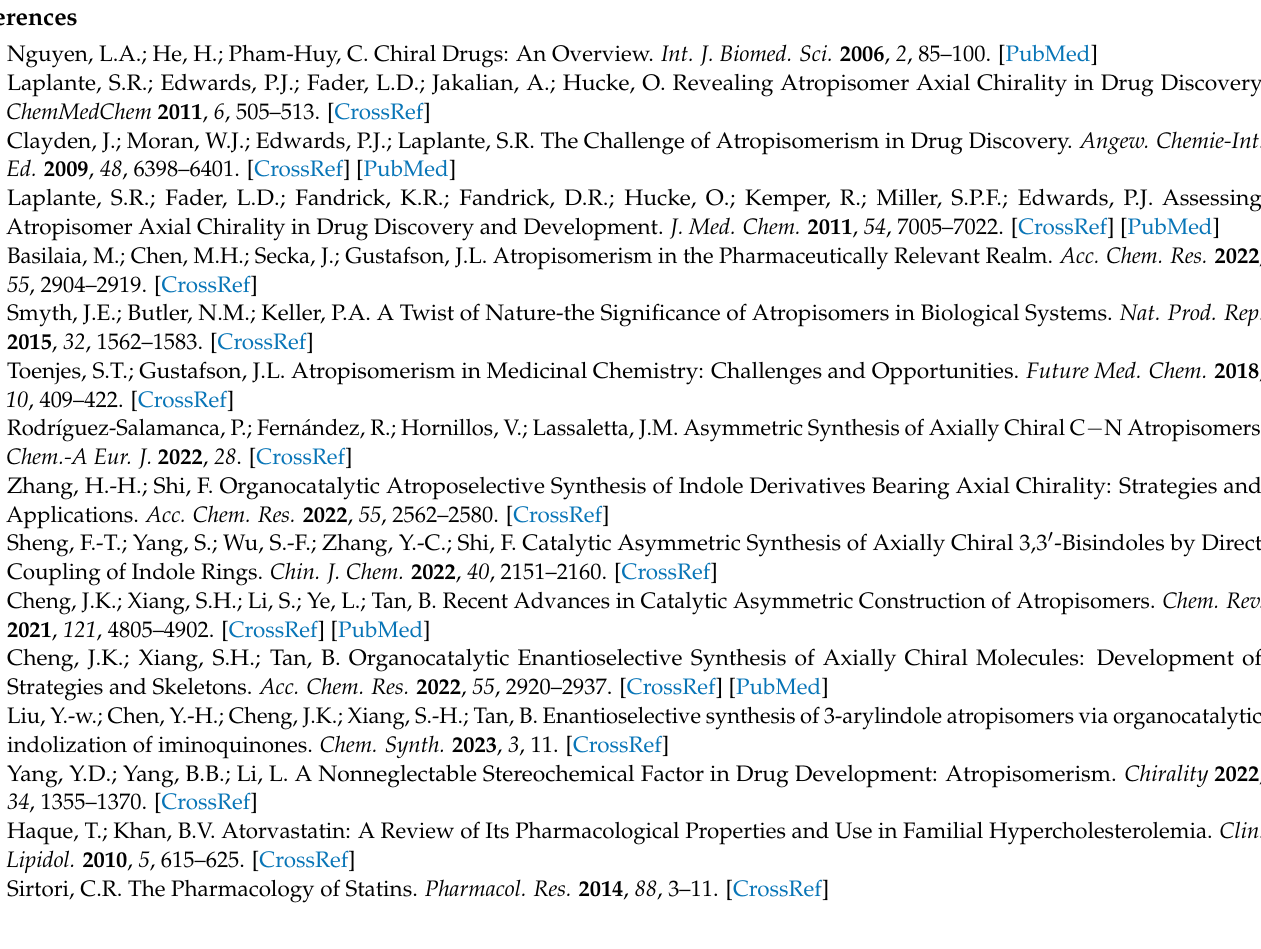
Pr of pyrrole 1a . Figure S2: D-HPLC of atorvastatin model 1b at +35 ◦ C, +40 ◦ C and +45 ◦ C. Figure S3: kinetic studies of reversible first-order racemization of atorvastatin model 1e . Figure S4: kinetic studies of reversible first-order racemization of atorvastatin model 1f . Figure S5: kinetic studies of reversible first-order racemization of atorvastatin model 1g . Figure S6: kinetic studies of reversible first-order racemization of atorvastatin model 1h . Figure S7: M -7g -model ground states geometries. Figure S8: ECD studies of compound M -7g -model. Figure S9: CSP-HPLC chromatogram of 5e’ . Figure S10: CSP-HPLC chromatogram of 1e’ and 4e’ . Figure S11: CSP-HPLC chromatogram of 5h’ . Figure S12: CSP-HPLC chromatogram of 1h’ and 4h’ . Figures S13–S60: NMR spectra. Scheme of synthesis. Molecular Docking. DFT calculated